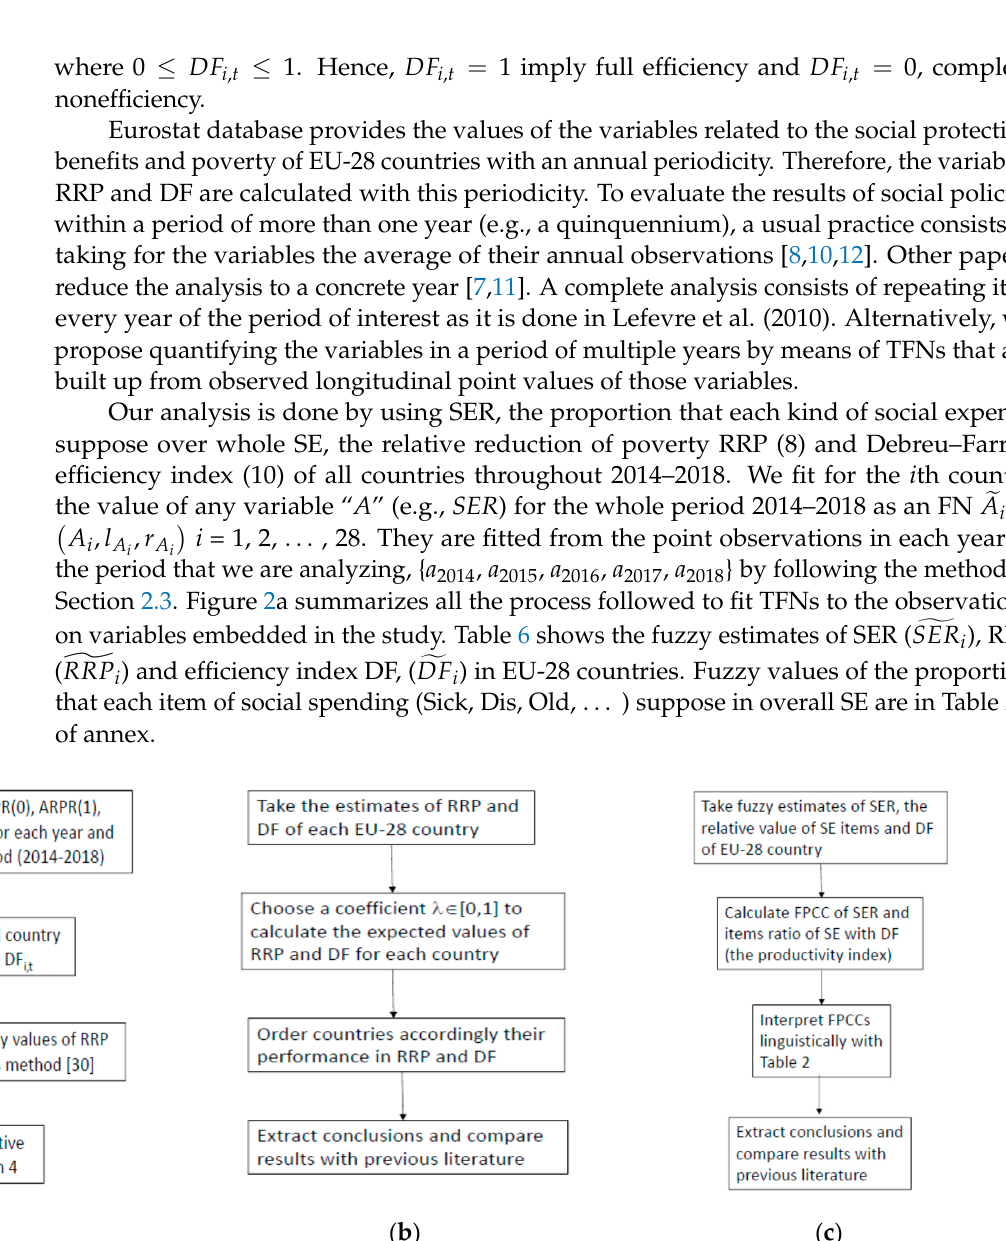
Table 9. Mean values of SER, poverty risk index (RRP) and Debreu–Farrell index (DF) in EU-28, EU-15 and non-EU-15 in the period 2014–2018.